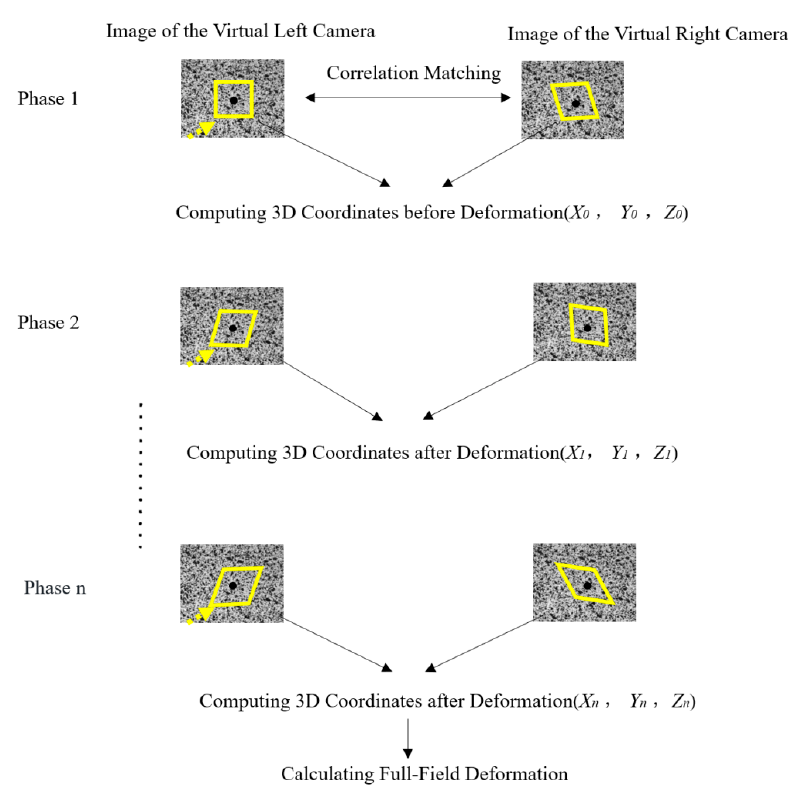
Figure 2. Flow chart of 3D-DIC method.